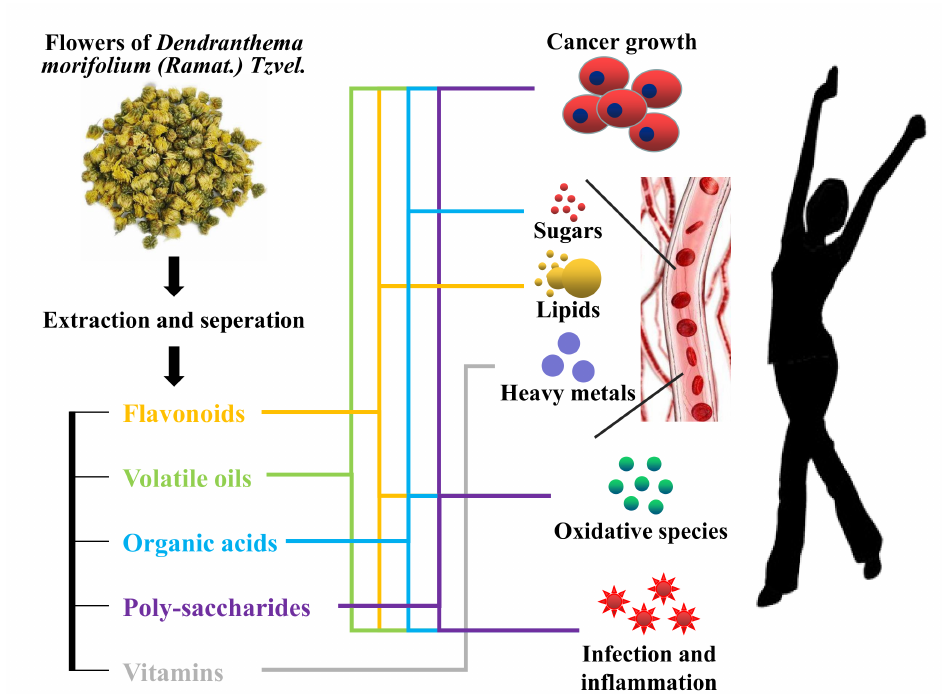
Figure 1. A summarization on the composition and possible pharmaceutical effects of Chrysanthemum